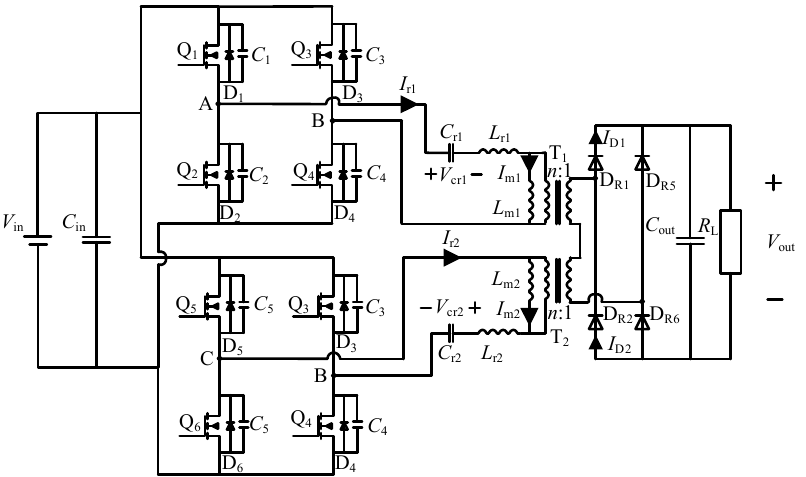
Figure 3. Equivalent circuit diagram of full ‐ bridge FM mode and full ‐ bridge phase ‐ shift mode.